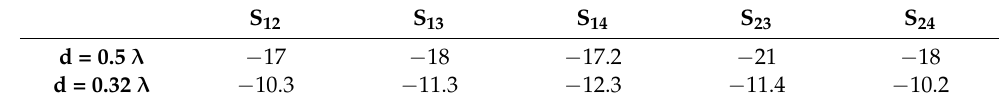
Figure 6. Measured reflection coefficient (H plane).